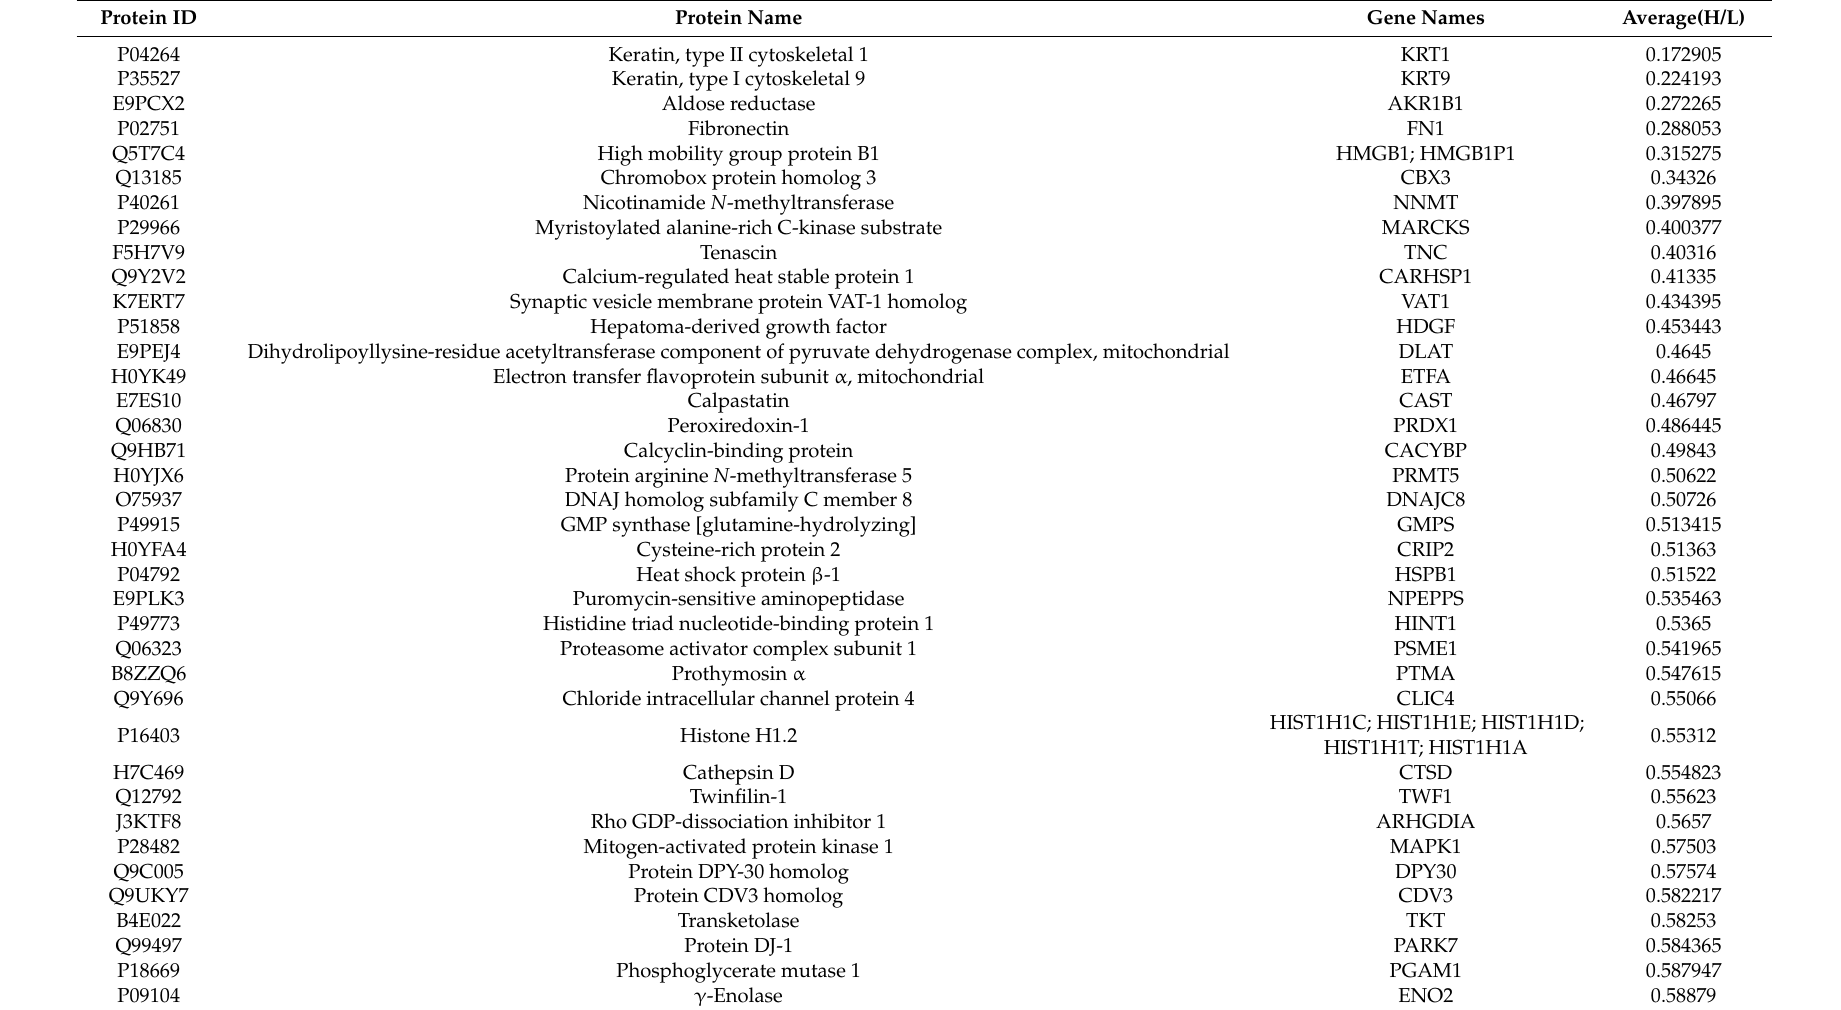
Table 1. 492 molecular proteins regulated by vancomycin in HK-2